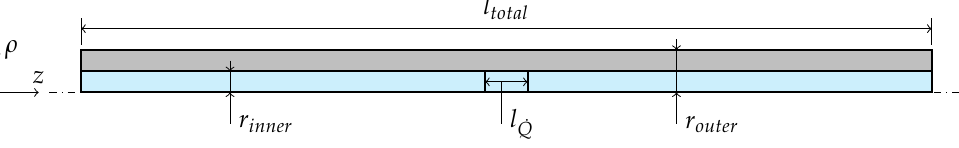
Figure 2. Cut view through the geometry under investigation. Half of the pipe and the center line of the rotational symmetry is shown. The fluid is shaded in blue and the pipe is shaded in gray. l ˙ Q depicts the width of the volume where heat enters the fluid, situated at the middle of the pipe’s length.